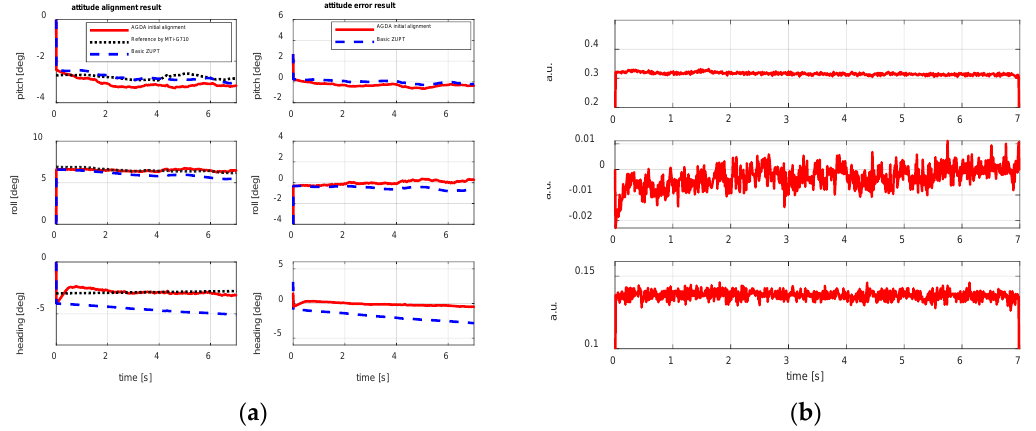
Figure 7. Attitude and magnetic disturbance estimation by initial alignment. ( a ) Attitude result; ( b ) Magnetic disturbance.